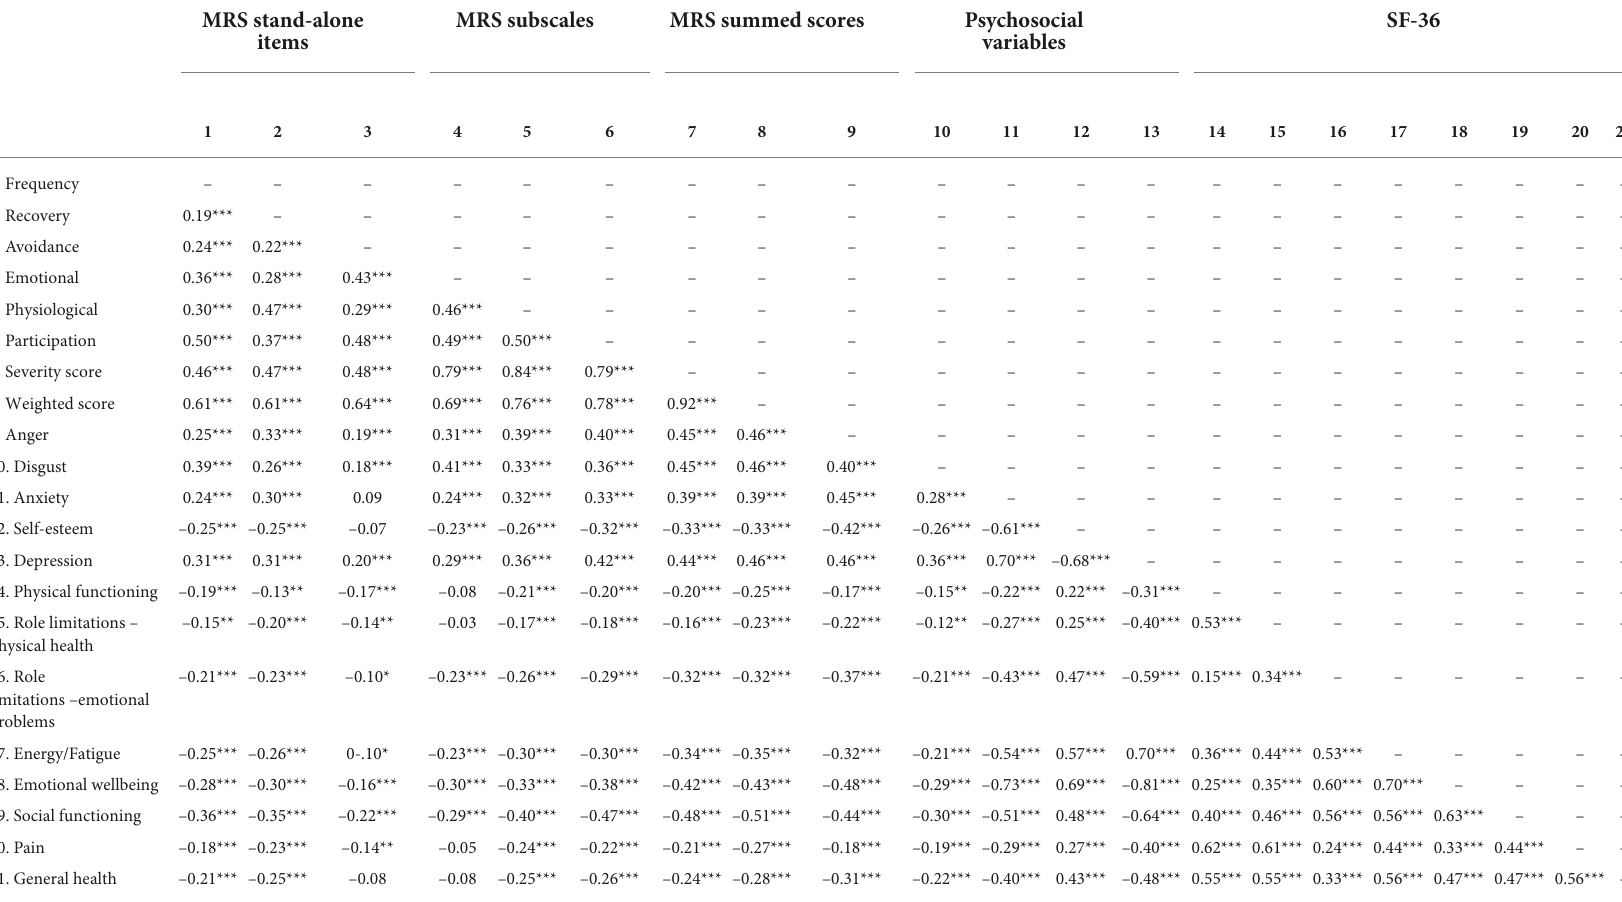
TABLE 8 Correlation coefficients between misophonic responses, psychosocial variables, and quality of life for misophonia group at baseline. MRS stand-alone